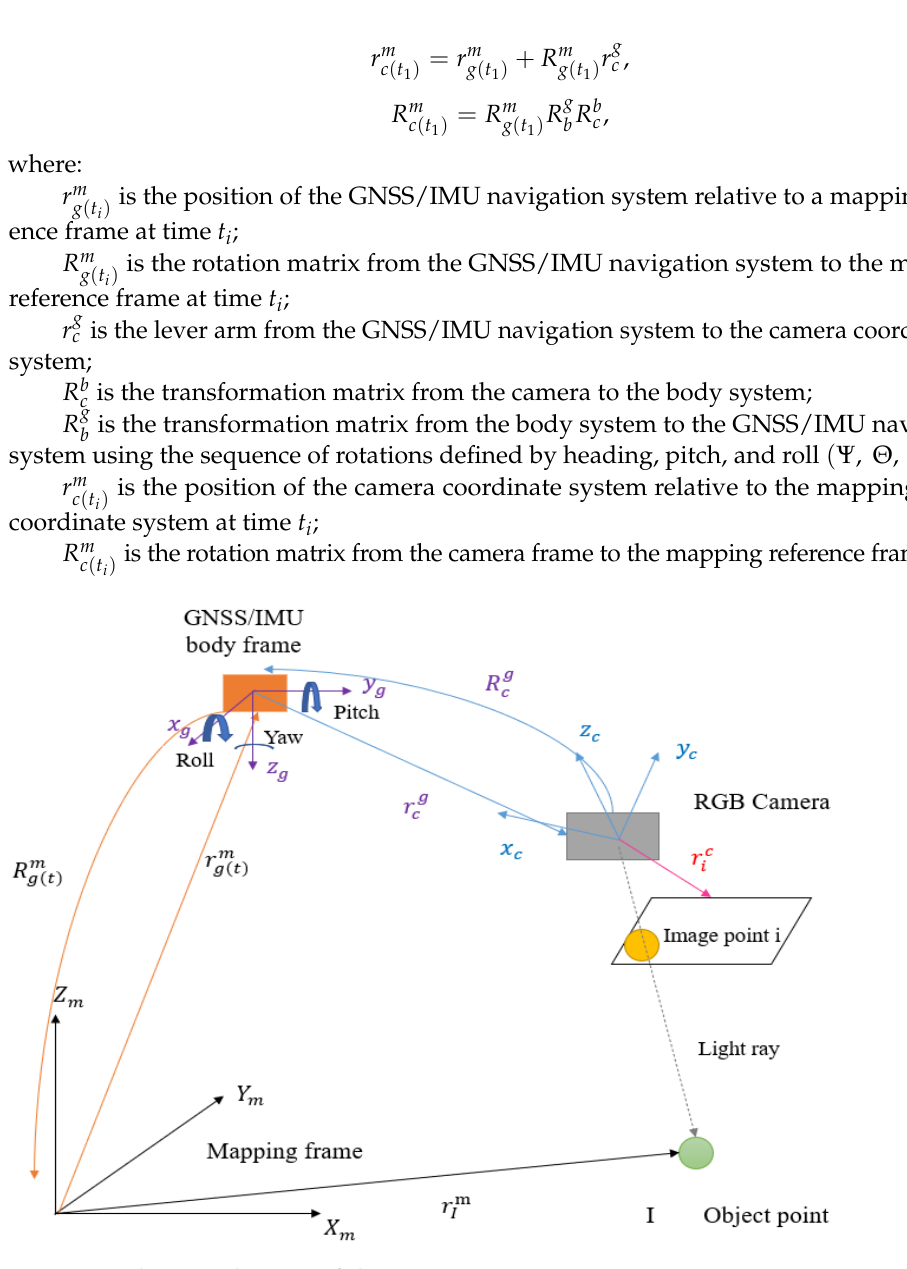
Figure 4. Schematic diagram of the point-positioning equations. Orange arrows represent the directions of signals and receptions between the GNSS/IMU body frame and the mapping frames. The blue arrows represent corresponding signal-reception directions between the GNSS/IMU body frame and the RGB camera, as well as the three-dimensional coordinate system of the camera. The purple arrows represent the coordinate systems of the GNSS/IMU body frame. The pink arrow represents the vector connection between the camera and the image at a given location point, i